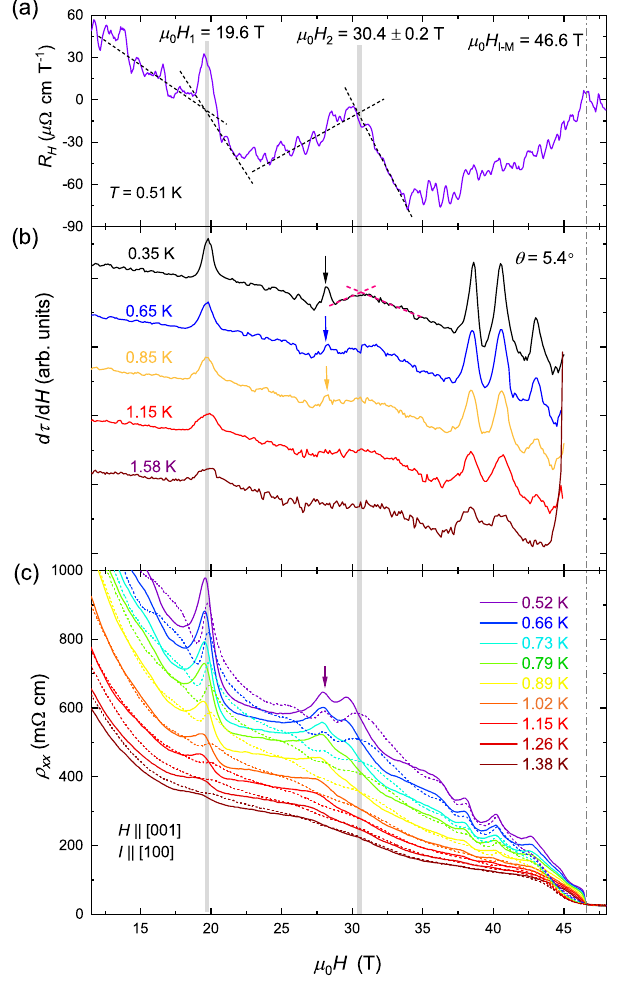
FIG. 4. Comparison of the field dependence of (a) Hall coefficient R , (b) field derivative of the magnetic torque H d τ =dH taken with tilt angle θ ¼ 5 . 4 ° between H and the [001] direction and (c) transverse resistivity ρ versus H applied along xx the [001] direction in YbB 12 . The insulator-to-metal-transition field μ 0 H is 46.6 T in this sample, as denoted by the vertical I − M dash-dotted line. Clear dHvA and SdH oscillations appear below H as shown in (b) and (c), respectively. The vertical gray thick I − M lines represent two characteristic fields: a nearly T -independent signature μ 0 H 1 ¼ 19 . 6 T manifested by (a) a slope change in R H H Þ , and a second signature and peaks in (b) d τ =dH and (c) ρ xx ð occurring at μ 0 H 2 ¼ 30 . 4 (cid:3) 0 . 2 T which is implied by the kinks in R and d τ =dH [dashed lines in (a) and (b), respectively]. This H latter feature roughly corresponds to a local maximum in MR for the down sweeps. Alternatively, the small cusp in d τ =dH at approximately 28 T (arrows) is identified as an extremum of quantum oscillations (see Fig. 12 and Appendix